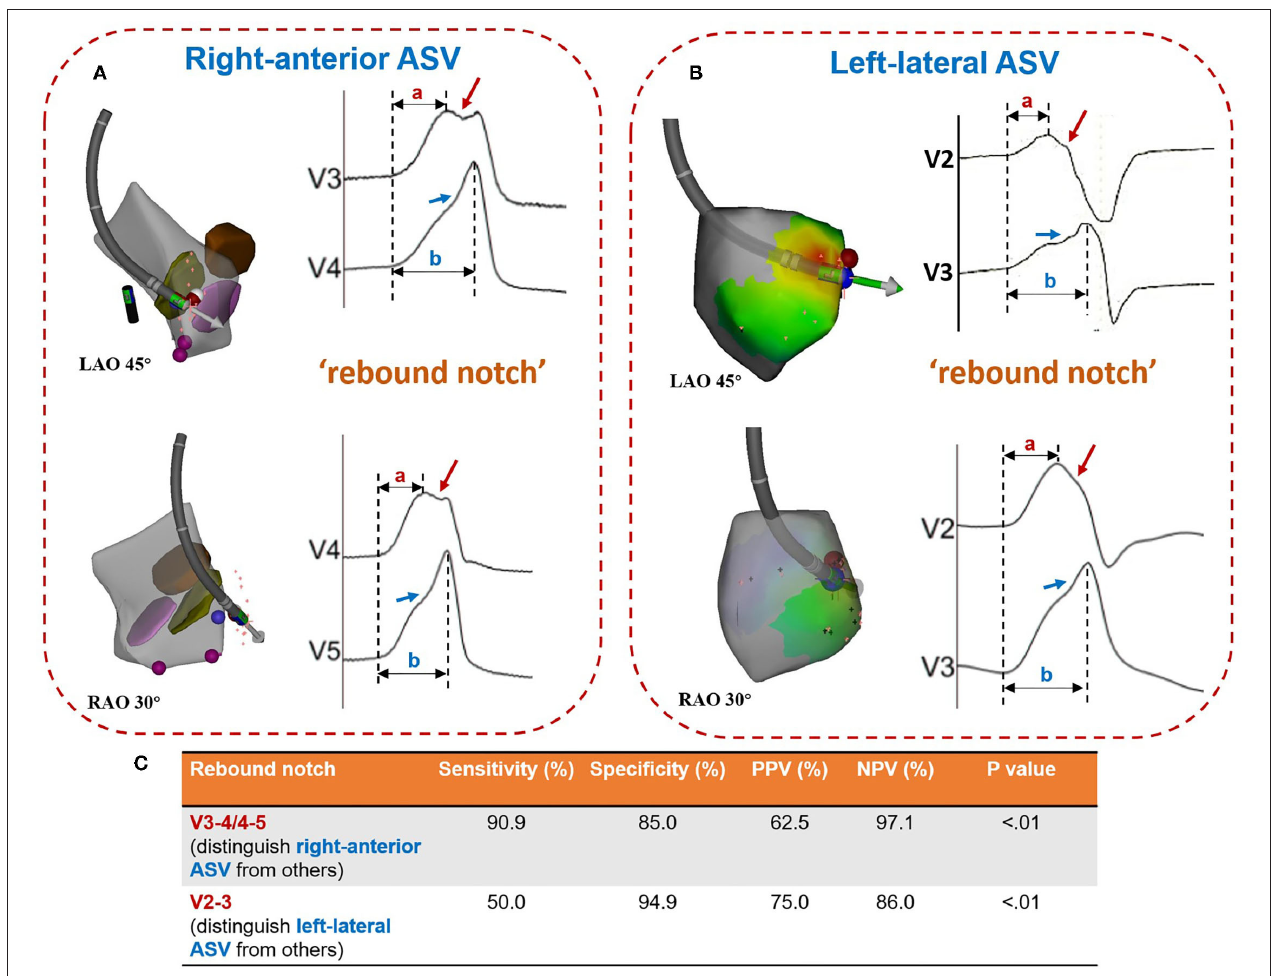
FIGURE 2 | Patterns of rebound notches on the precordial lead. (A) Left-sided (V3-V5) rebound notches (a downstroke notch on the earlier lead followed by an upstroke notch on a later lead; peak R-wave deflection interval: (a < b) is more common in ventricular arrhythmias ablated in the right-anterior ASV. (B) Right-sided (V2-V3) rebound notches are more common in ventricular arrhythmias ablated in the left-lateral ASV. (C) The accuracy of rebound notches in identifying ventricular arrhythmias originating from the right-anterior ASV and/or the left-lateral ASV. ASV, aortic sinus of Valsalva; PPV, positive predictive value; NPV, negative predictive